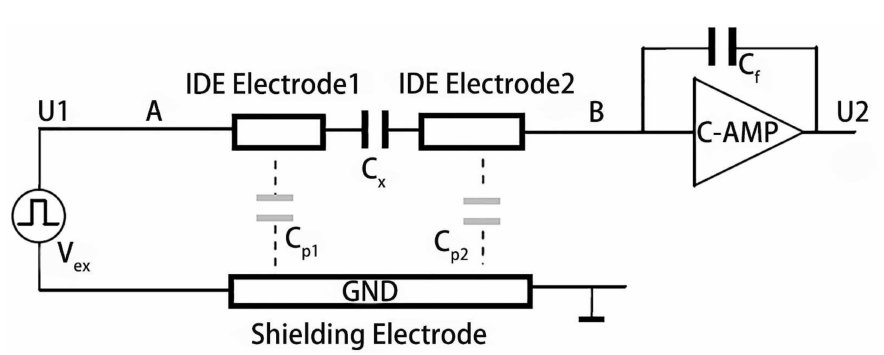
Figure 7. The working principle of the humidity capacitance measurement. The key point is to calculate the capacitance of C x by measuring the induced charge generated at point